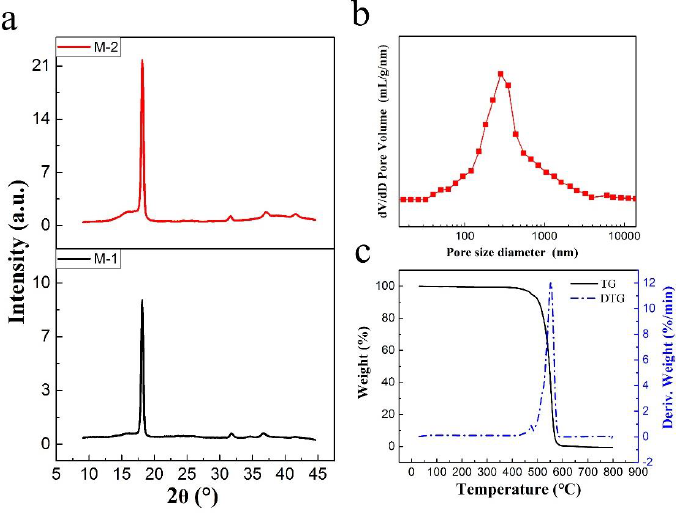
Figure 3. SEM images and the corresponding 3D confocal laser scanning microscope (CLSM) images of the sintered ultrafine fibrous PTFE hollow fiber membranes: ( a ) the sintered M-1 membrane; ( b ) the sintered M-2 membrane; ( c ) the sintered M-3 membrane; (1) surface × 800; insets were the photos of WCA; (2) surface × 5000; (3) the cross-section; (4) 3D CLSM images.